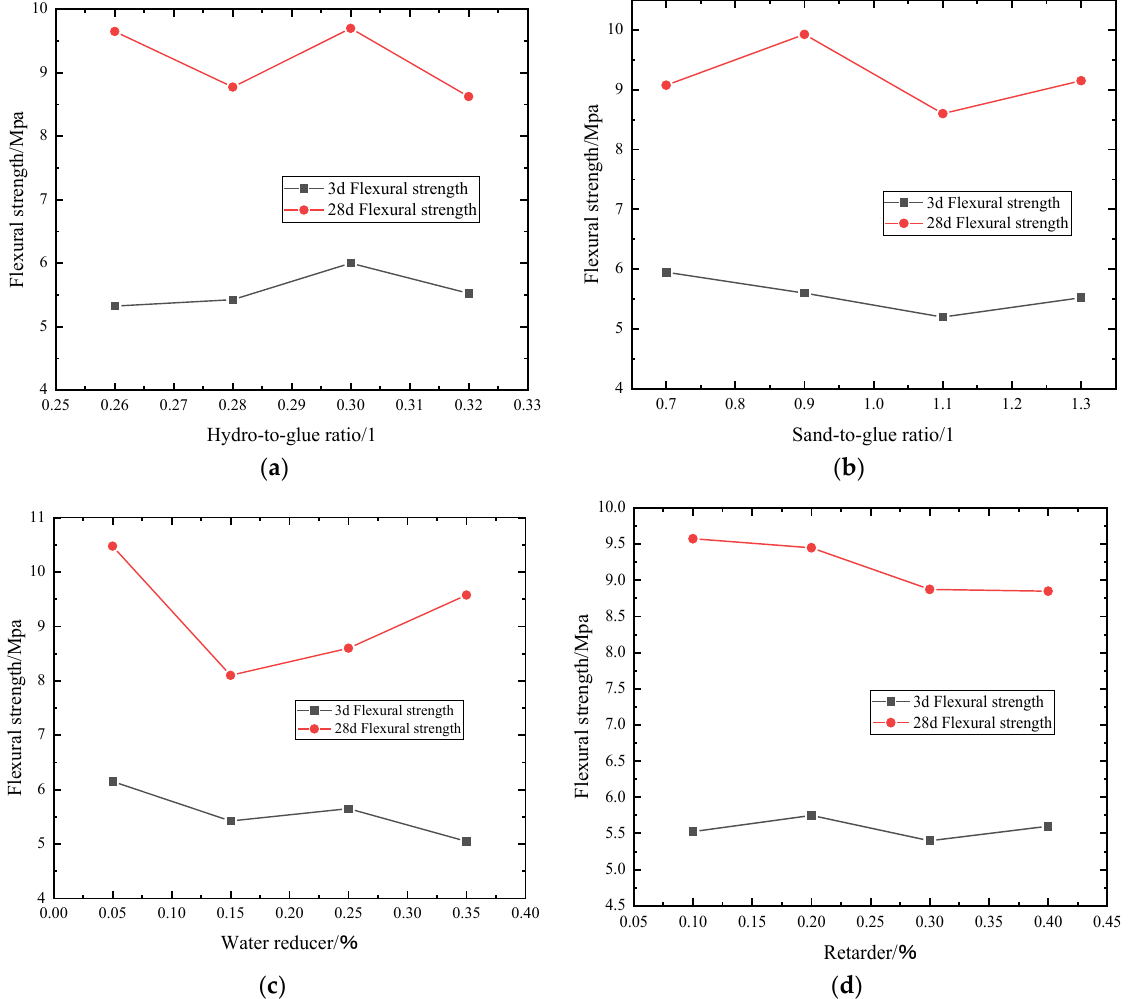
Figure 5. Influence of various factors on the flexural strength at 3 d/28 d. ( a ) Water-to-glue ratio; ( b ) Sand-to-glue ratio; ( c ) Water reducer; ( d ) Retarder .